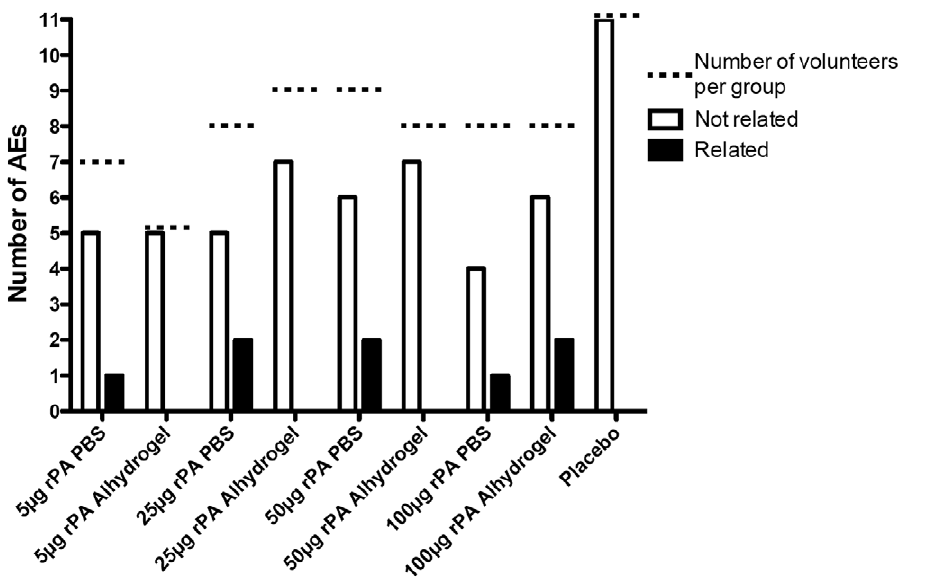
Figure 3. Adverse events (AEs). The number of AEs was tallied for each dosage group, as well as all of the placebos, who were combined into one group. The empty bars represent AEs that were determined to be not related to the vaccine. The filled bars represent AEs that were determined to be related to the vaccine. The dotted line indicates the total number of volunteers in each group. All AEs that were determined to be related to the vaccine were mild in severity.